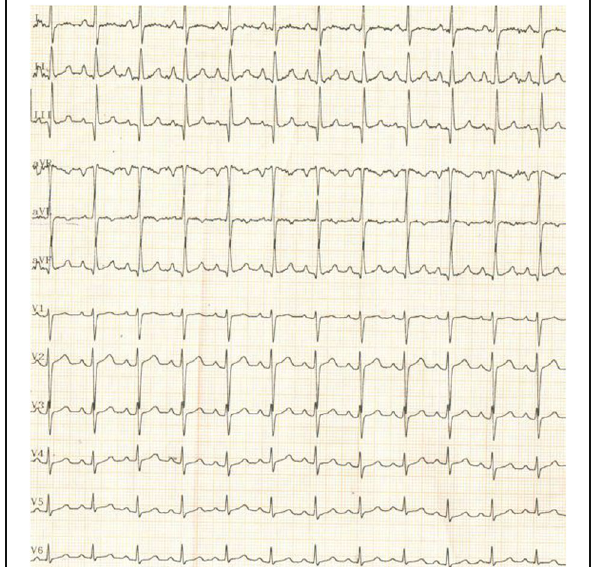
Fig. 1 Twelve lead ECG showing sinus tachycardia